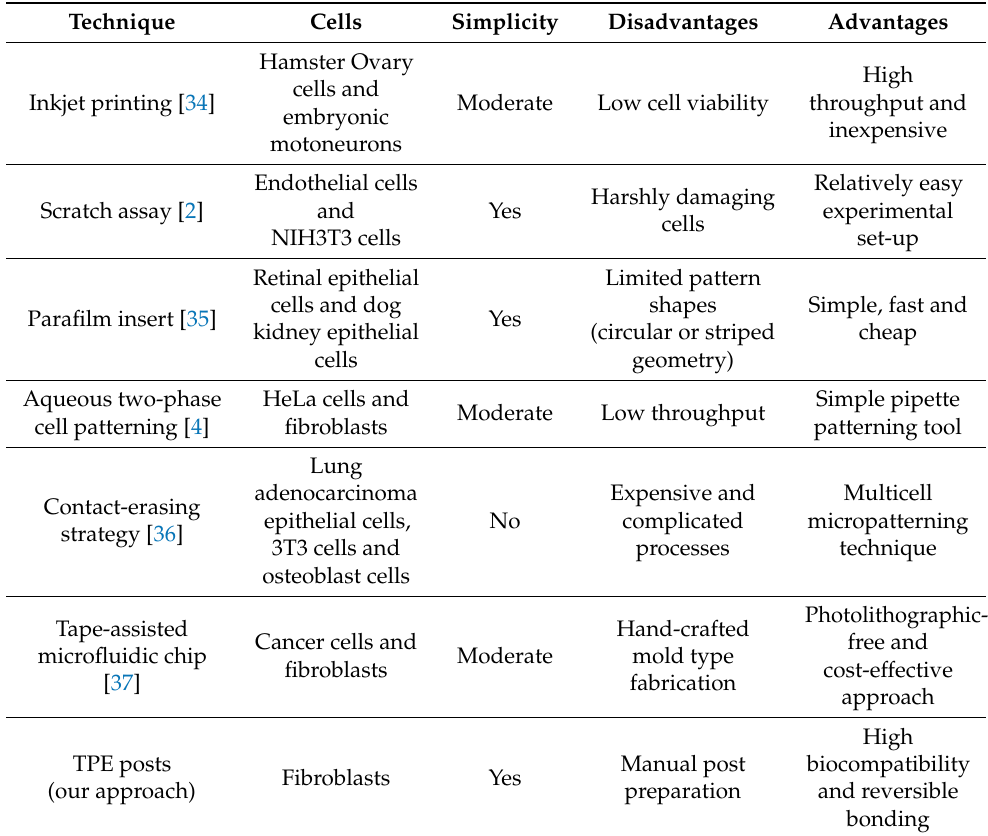
Table 1. Comparison study of cell patterning